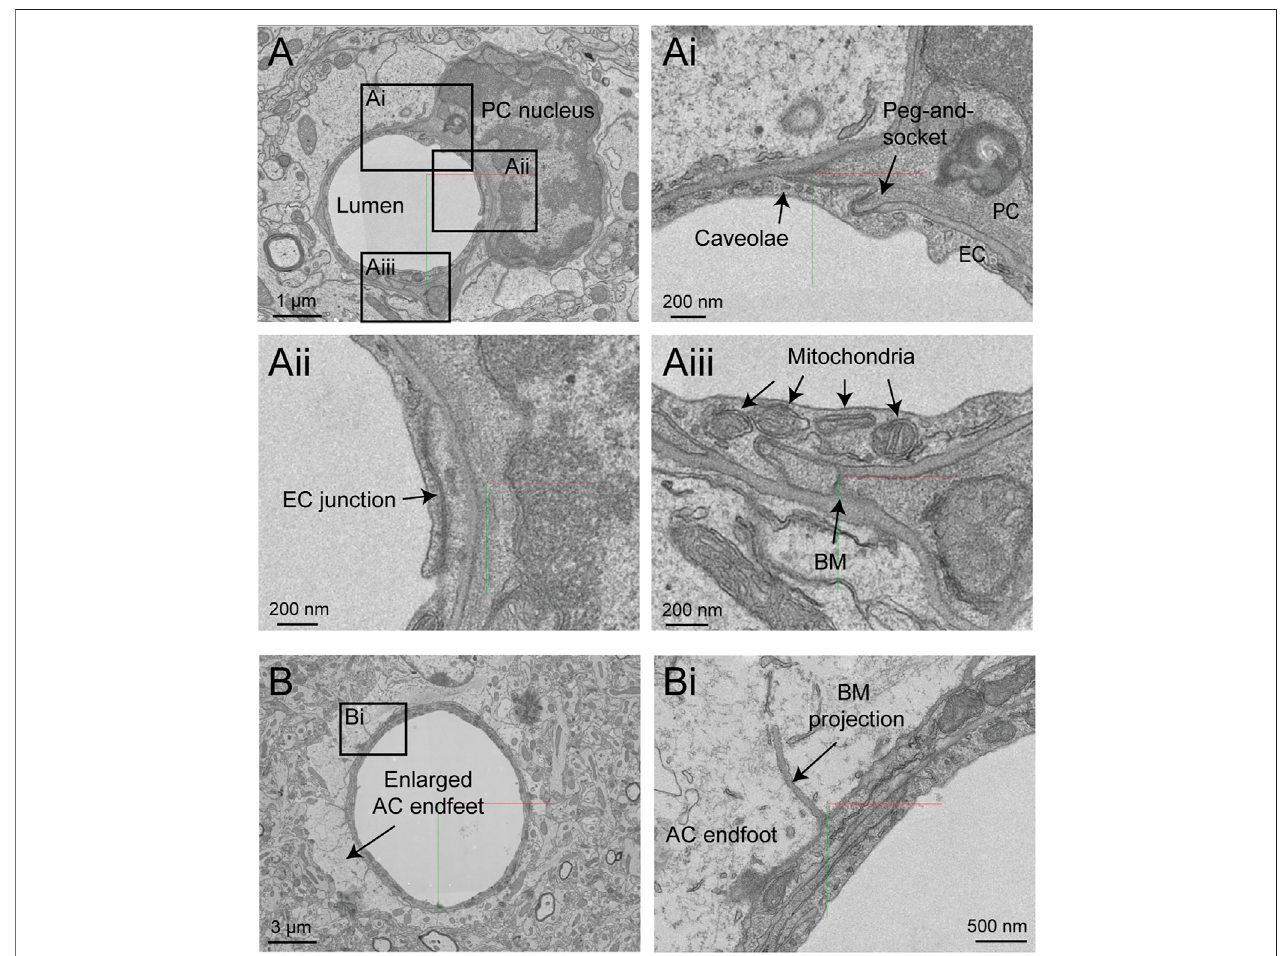
FIGURE 11 | Ultrastructural view of microvasculature in the mouse hippocampus. (A) Representative images from data of Bloss et al. taken from mouse hippocampus. The image shows a capillary cross-section where a pericyte soma is located. Insets from (Ai – Aiii) show a variety of subcellular structures that can be visualized. Coordinates at: 20865, 54458, 146. (B) A separate capillary cross-section taken from the same volume exhibits enlarged astrocytic endfeet against the vascular wall. An inset (Bi) shows a thin projection of the basement membrane extending abluminally. Coordinates at: 25774, 59225, 86.